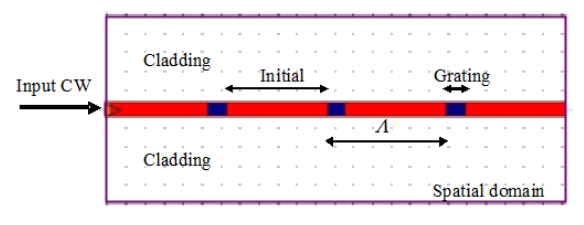
Fig. 3 LPFG structure in FullWAVE (Synopsys Inc.).